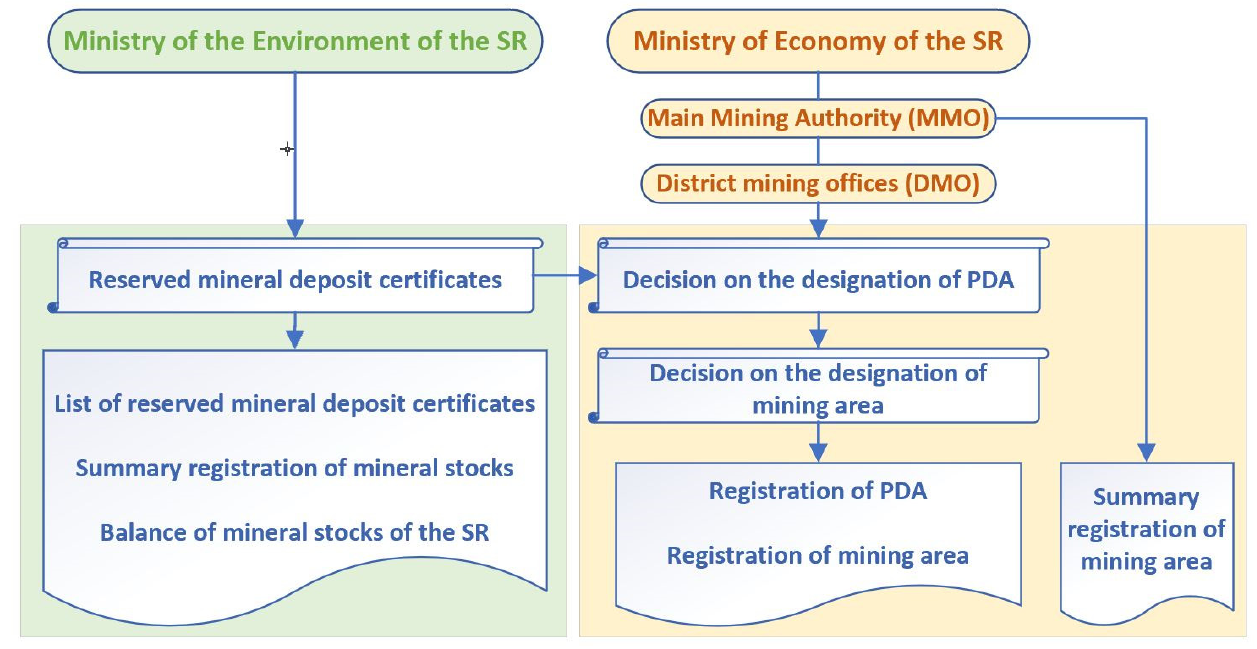
Figure 3. Management and registration of PDA documents is the responsibility of the ministries of the SR.